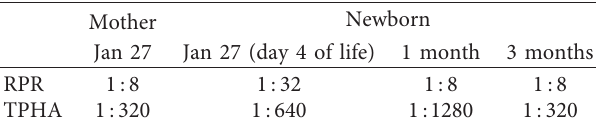
Table 3: Syphilis serological